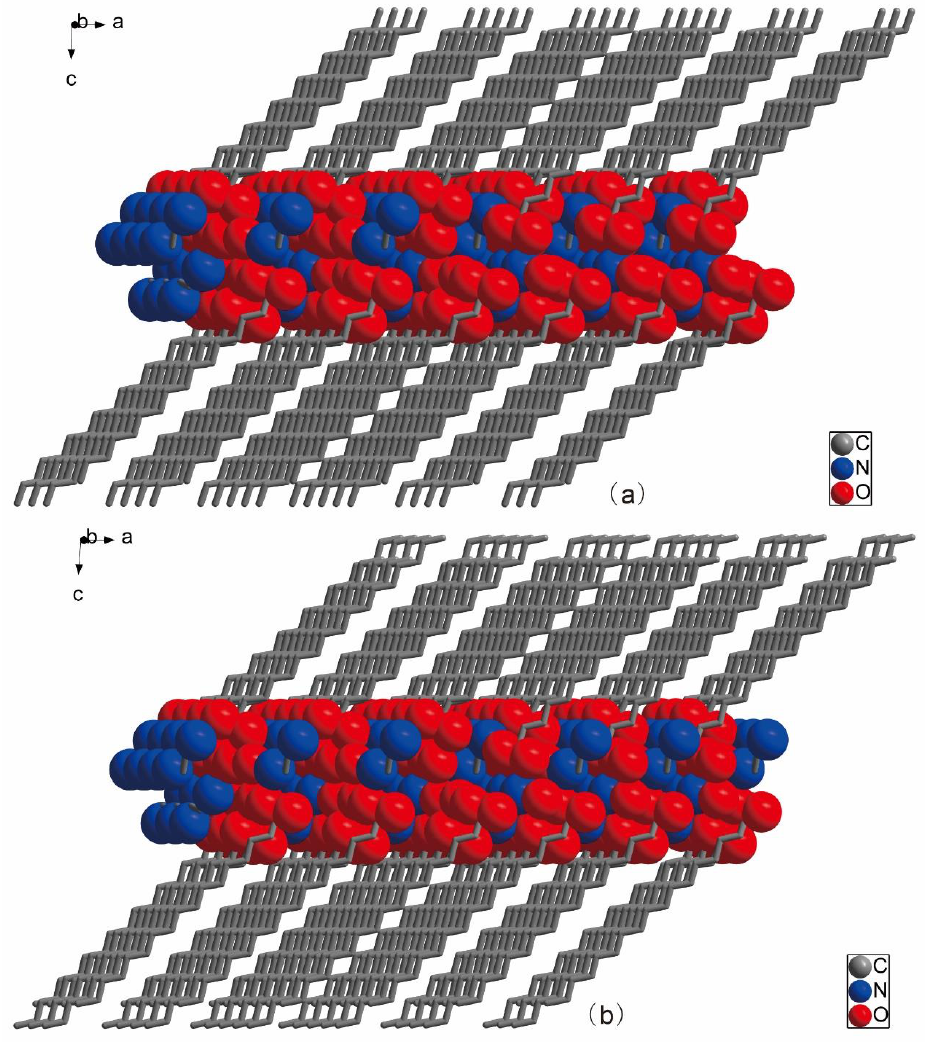
Figure 4. Three-dimensional space-filling diagrams of the two molecules: where ( a ) represents 3C16 and ( b ) represents 3C17.